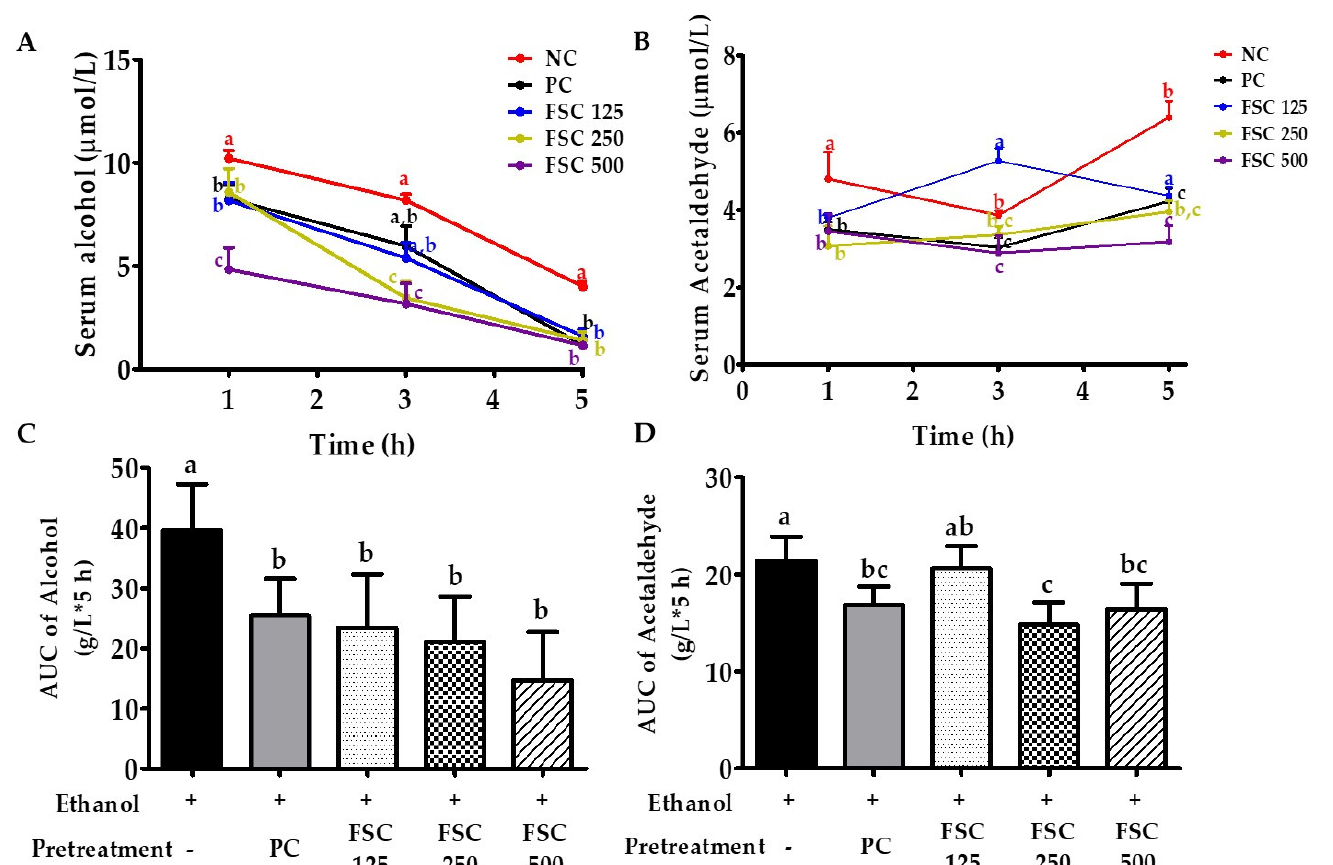
Figure 3. The effect of FSC on blood concentration and AUC of alcohol ( A , C ) and acetaldehyde ( B , D ) in alcohol-loaded rats before and after acute alcohol consumption. Briefly, rats were orally administrated water, Condition ® , or FSC. Then, after 30 min, a dose of ethanol (3 g/kg) was administered. Blood was collected from the tail vein at 1, 3, and 5 h after ethanol administration. Group NC, oral administration of 3 g/kg b.w. of alcohol only; Group PC, pretreated with Condition ® ; Group FSC 125, FSC 250, and FSC 500, pretreated with FSC at 125, 250, and 500 mg/kg b.w., respectively. Data represent the mean ± SEM (n = 6). Bars with different letters show significant differences between groups ( p < 0.05) determined by analysis of variance and Tukey’s multiple comparison